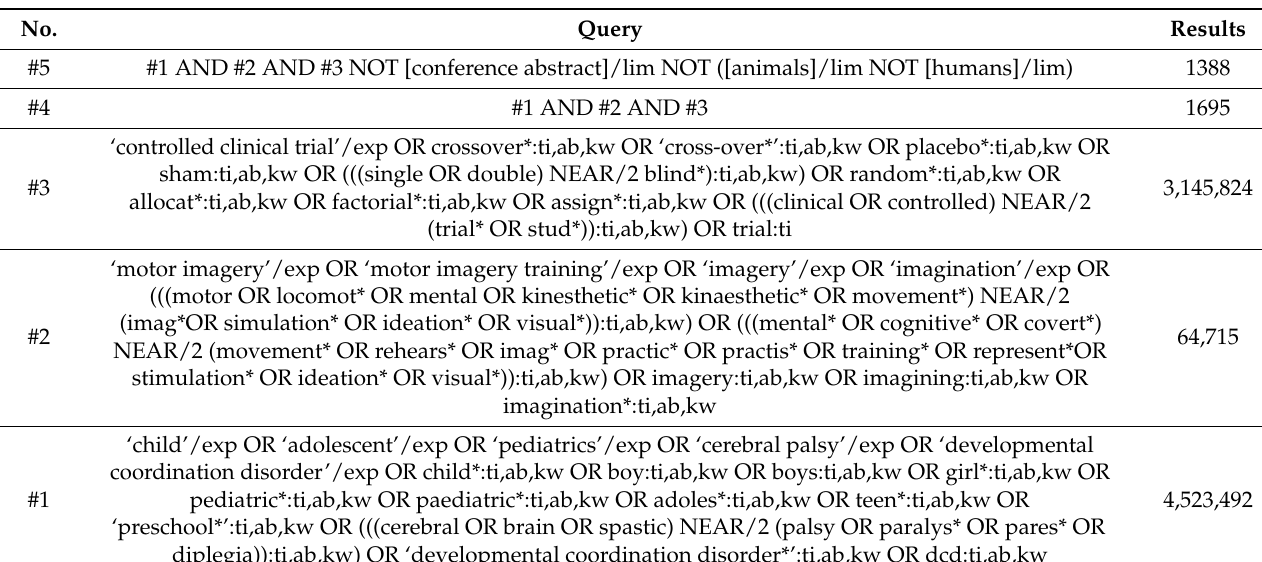
Table 1. Search terms and strategy of the Embase